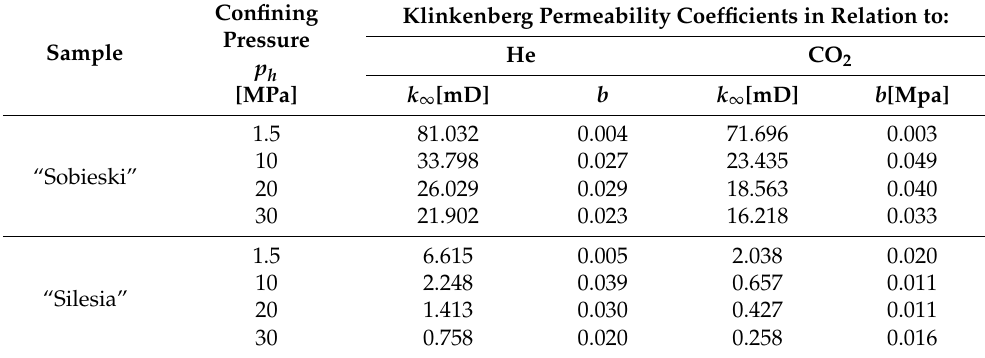
Table 3. Results of coal permeability to He and CO 2 at different confining pressures.